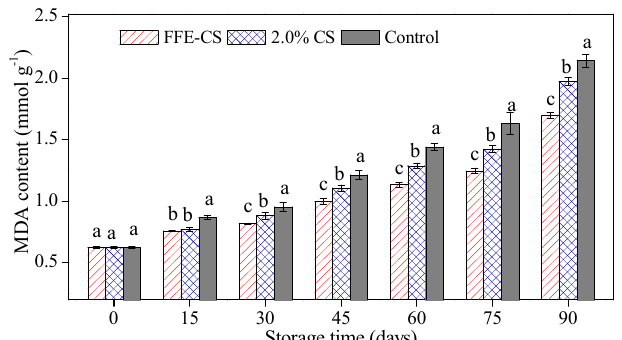
Figure 5. Effect of FFE–CS coating on malondialdehyde (MDA) content of Xinyu tangerines